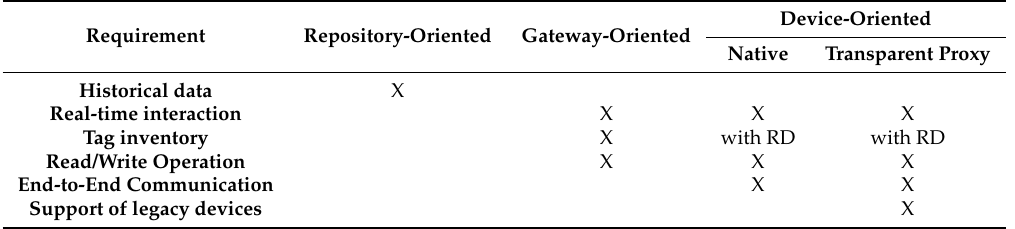
Table 1. Comparison among the discussed integration approaches. RD, Resource Directory.